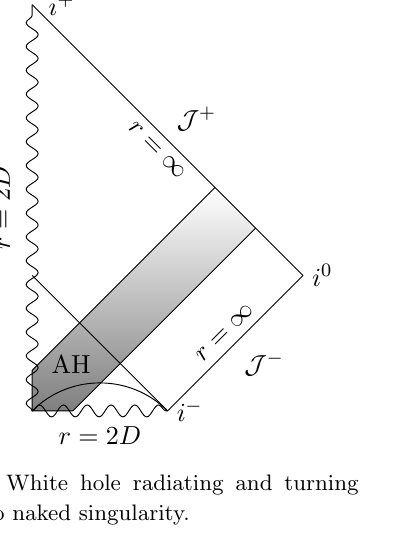
(b) Black hole accreting null dust.